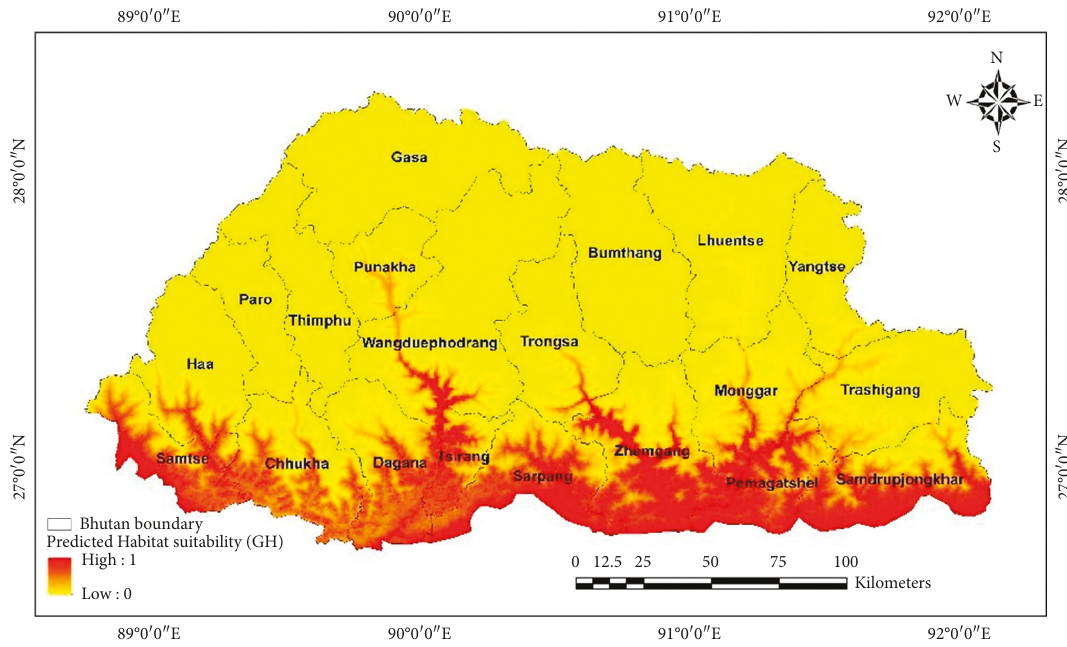
Figure 4: Predicted GH occurrence map from low to high probability